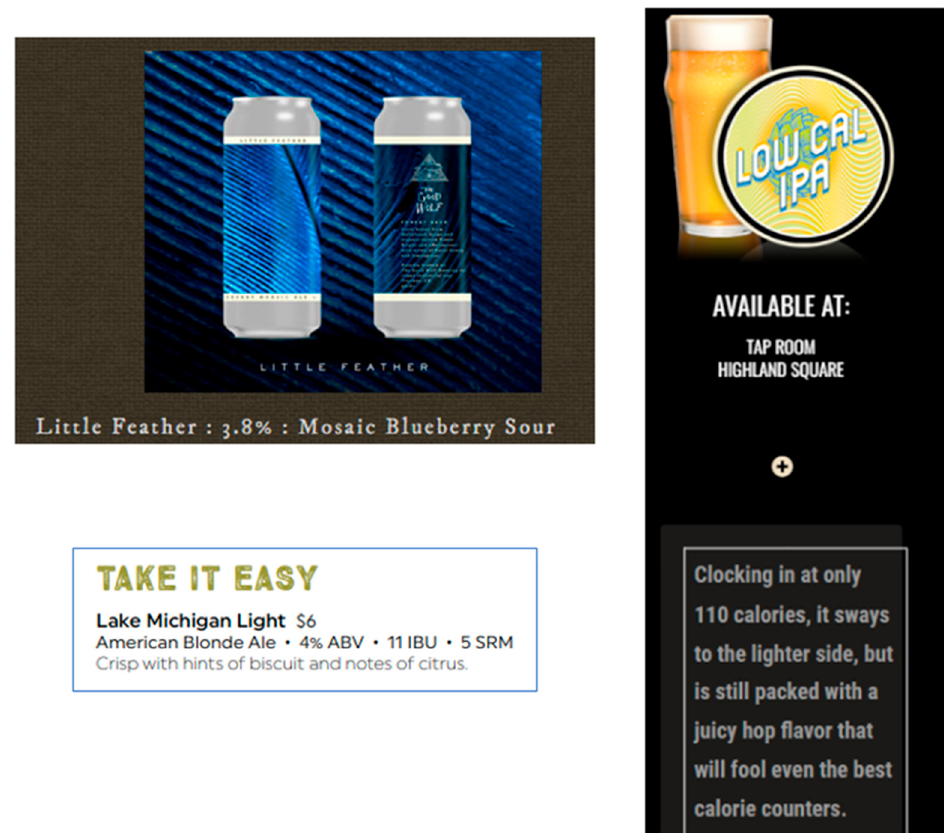
Figure 6. Examples of how low ABV offerings are represented. ( Screenshots collected by the authors from http://www.thegoodwolfbrewing.com/, https://www.schlafly.com/, and https://roundbarn.com/pubhouse; 30 July 2022).